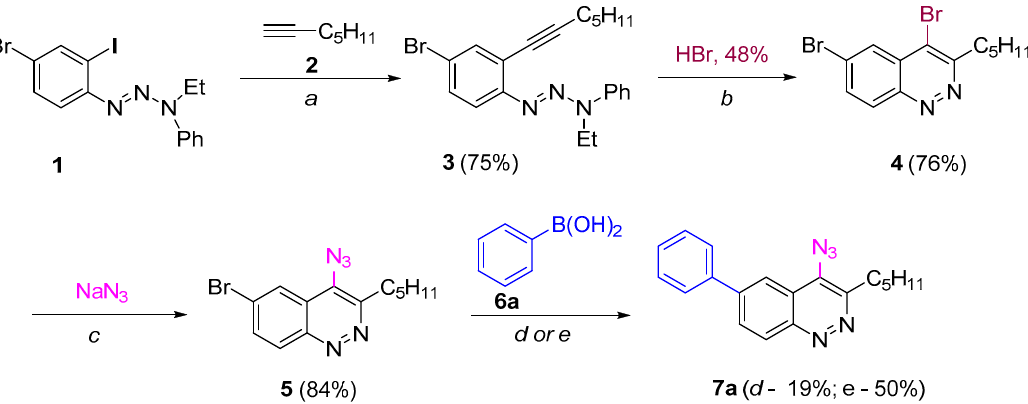
Scheme 2. Synthesis 6-aryl-4-azidocinnolines through “Route A”. Reagents and conditions: ( a )